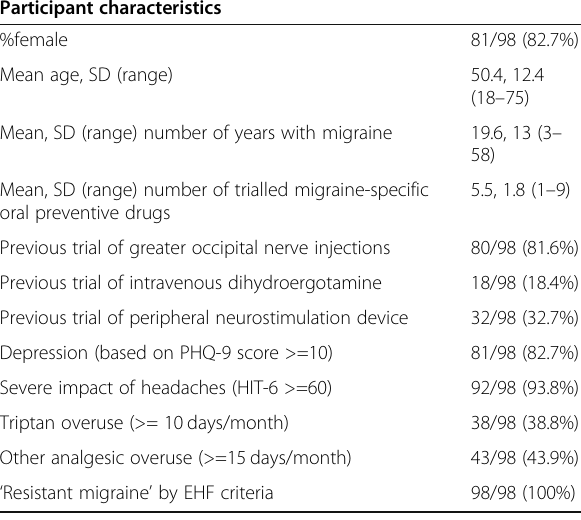
Table 1 Demographic factors in patients receiving erenumab Participant characteristics